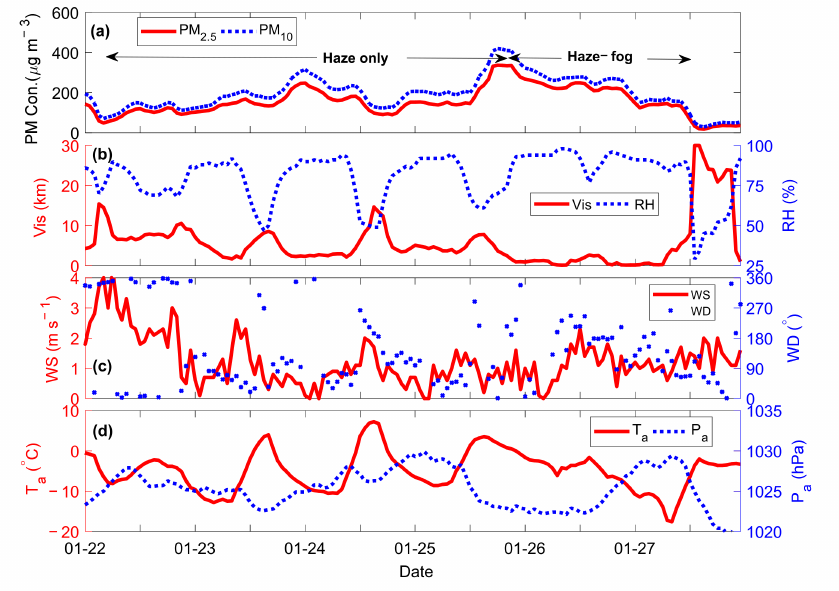
Figure 2. Variation in hourly mean ( a ) mass concentrations of PM 2.5 and PM 10 , ( b ) atmospheric visibility and relative humidity, ( c ) wind speed and direction, and ( d ) air temperature and air pressure at 2 m height in Shenyang on 22–27 January